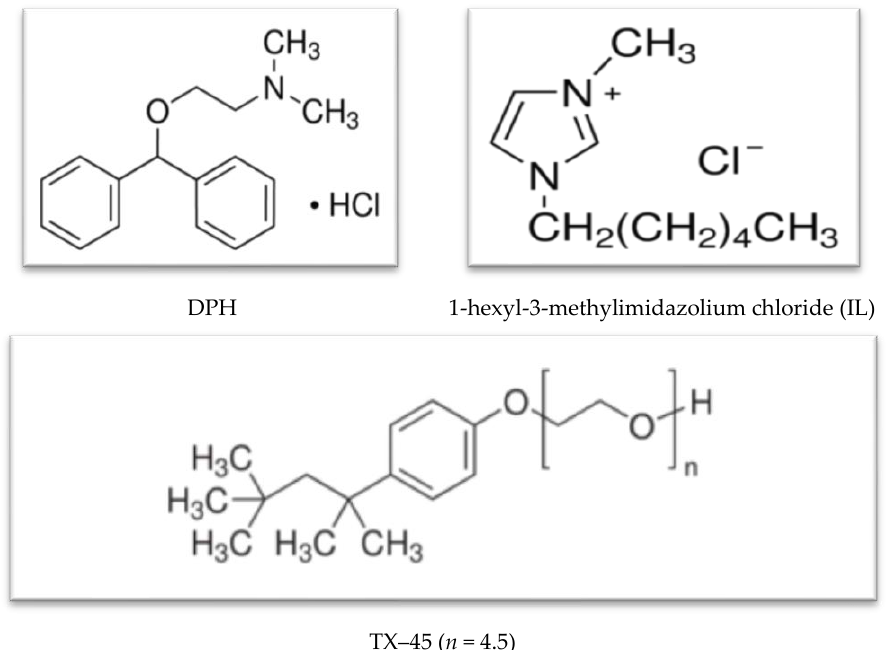
Figure 1. Structure of diphenhydramine hydrochloride (DPH), 1-hexyl-3-methylimidazolium chlo- ride (IL), and triton X – 45 (TX – 45).